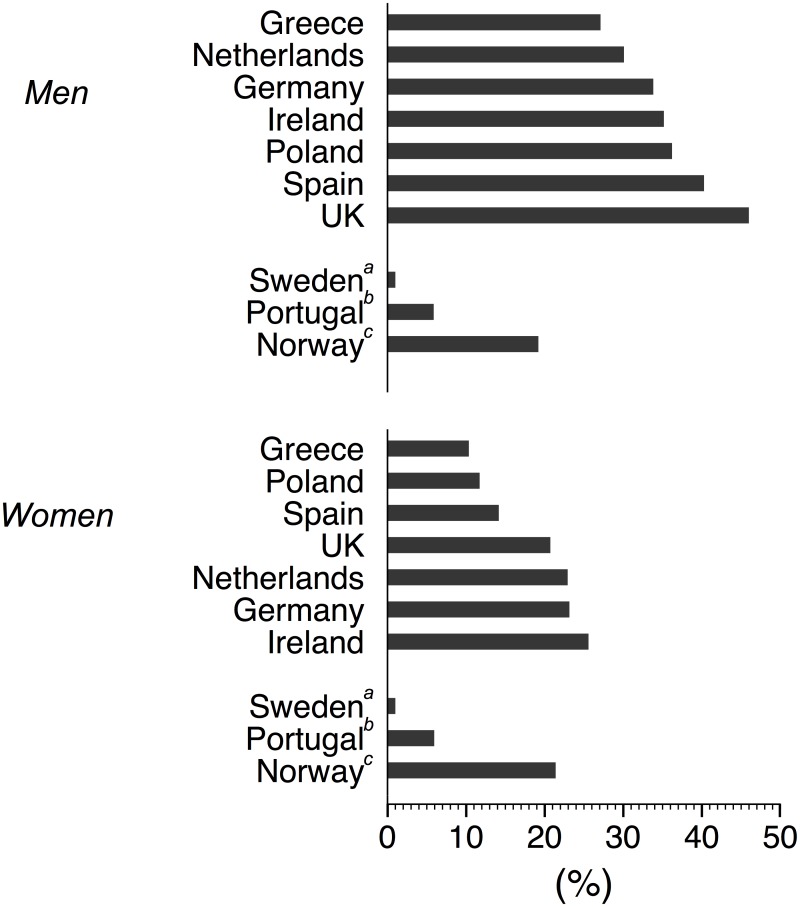
Proportion of subjects meeting the 30 min.d-1 Physical Activity (PA) recommendations by country.aSwedish data: Hagstömer et al. [18]; bPortuguese data: Baptista et al. [17]; cNorwegian data: Hansen et al. [19]; Prevalence estimates from the present study are adjusted for age, waist circumference, season, accelerometer wear time and smoking.